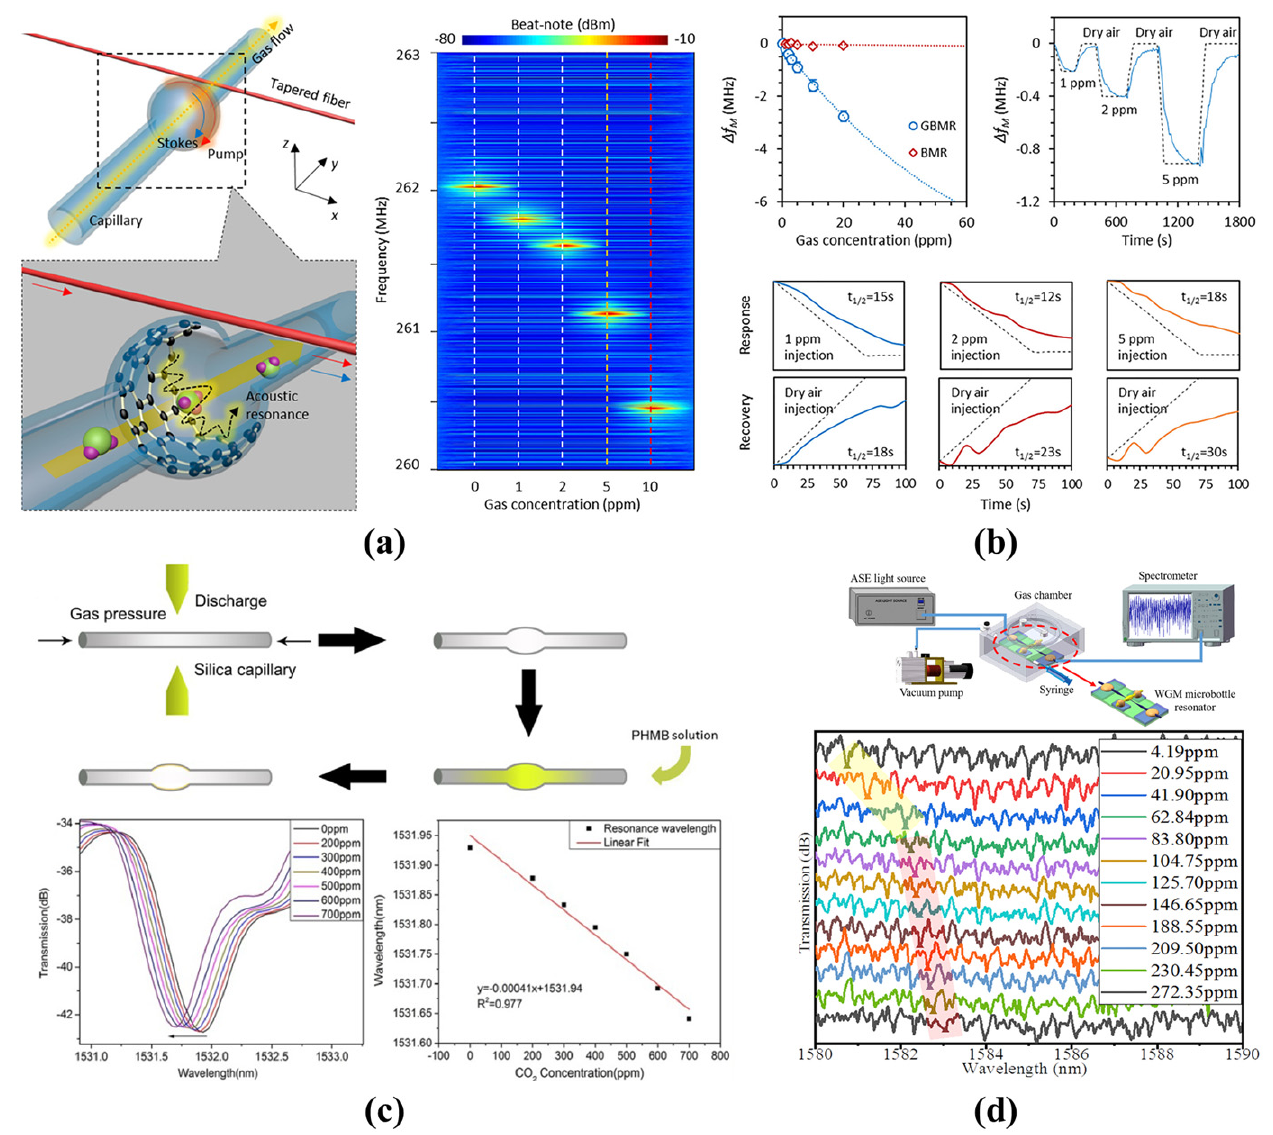
Figure 11. Gas sensing with microbubble resonators: ( a , b ) a graphene-deposited microbubble for the ammonia gas sensing (reprinted with permission from [122], © ACS Publications); ( c ) a PHMB- deposited microbubble for the CO 2 gas sensing (reprinted with permission from [123], © Optica, formerly the Optical Society of America); ( d ) a PDMS-deposited microbubble for the ethanol gas sensing (reprinted with permission from [111], © Elsevier).